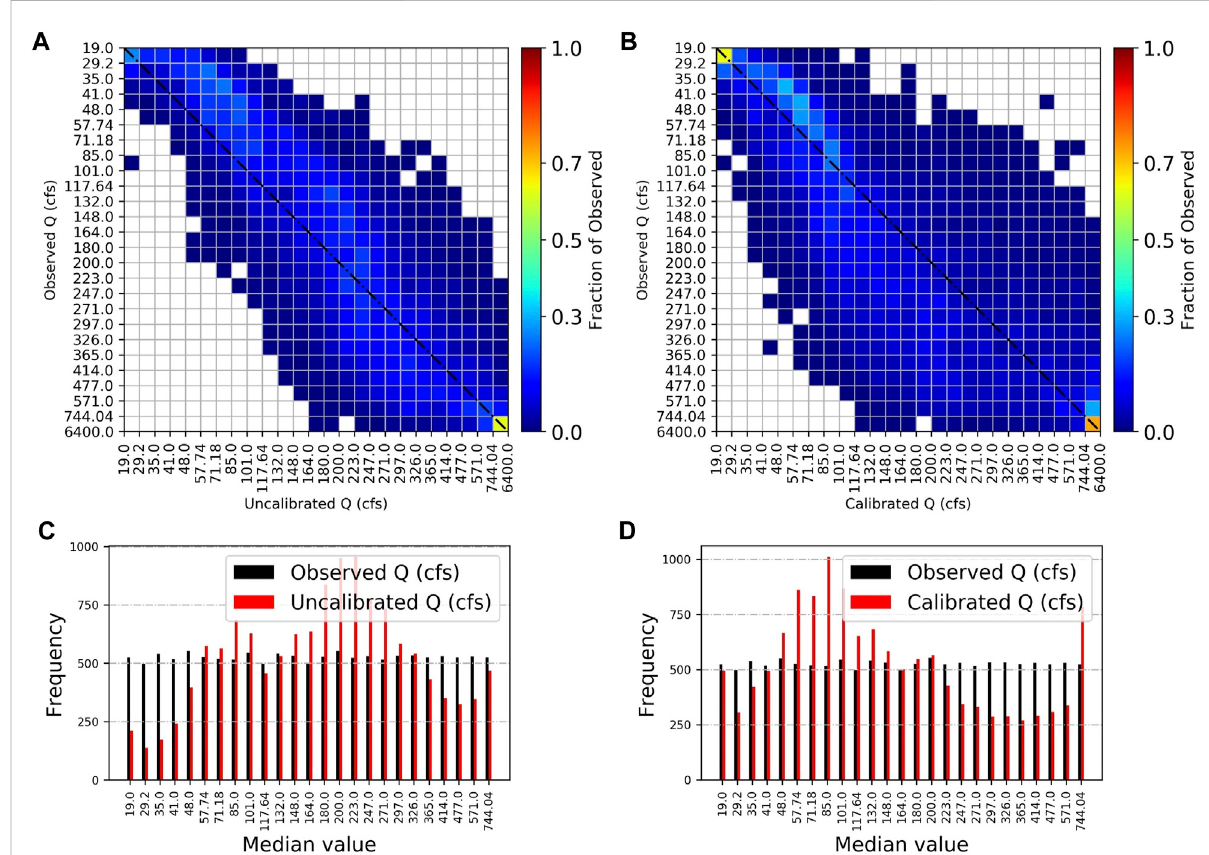
FIGURE 6 Time-linked fl owdurationcurvefor (A) theuncalibratedmodeland (B) thecalibratedmodel (C) thesumofthenumberofsimulated fl owsinthe same fl ow range bin as the observed for the uncalibrated model and (D) the same as C but for the calibrated model. Figures (A,B) show how the observed fl ows in each bin are distributedacross thebins of the model estimated fl ows. The number of bins, auser-de fi ned value, is25 here. Ideally, hot colors would populate the diagonal, implying minimum over/underestimations.